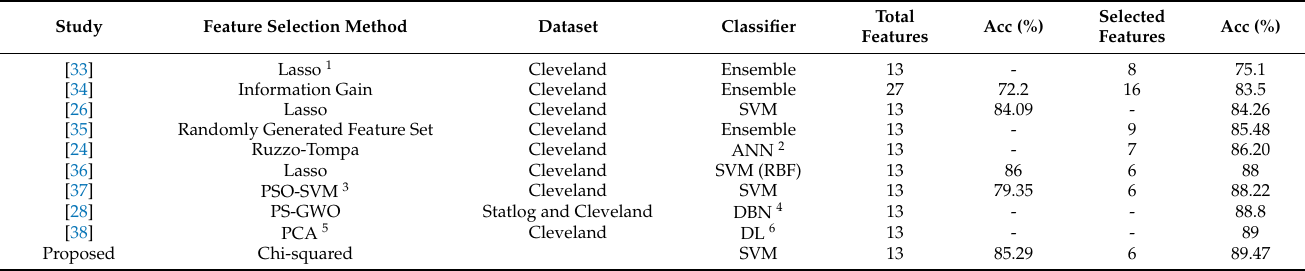
Table 5. Proposed model comparative analysis with current state-of-the-art